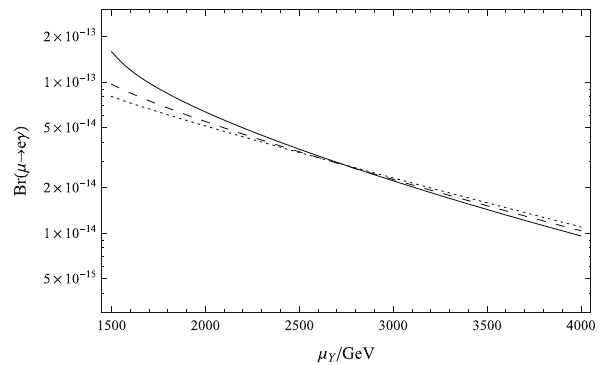
Fig. 9 With B Y = 0 . 4 ( 0 . 8 , 1 . 2 ) TeV, the branching ratios of μ → e γ versus parameter μ Y are plotted by the dotted, dashed and solid lines respectively